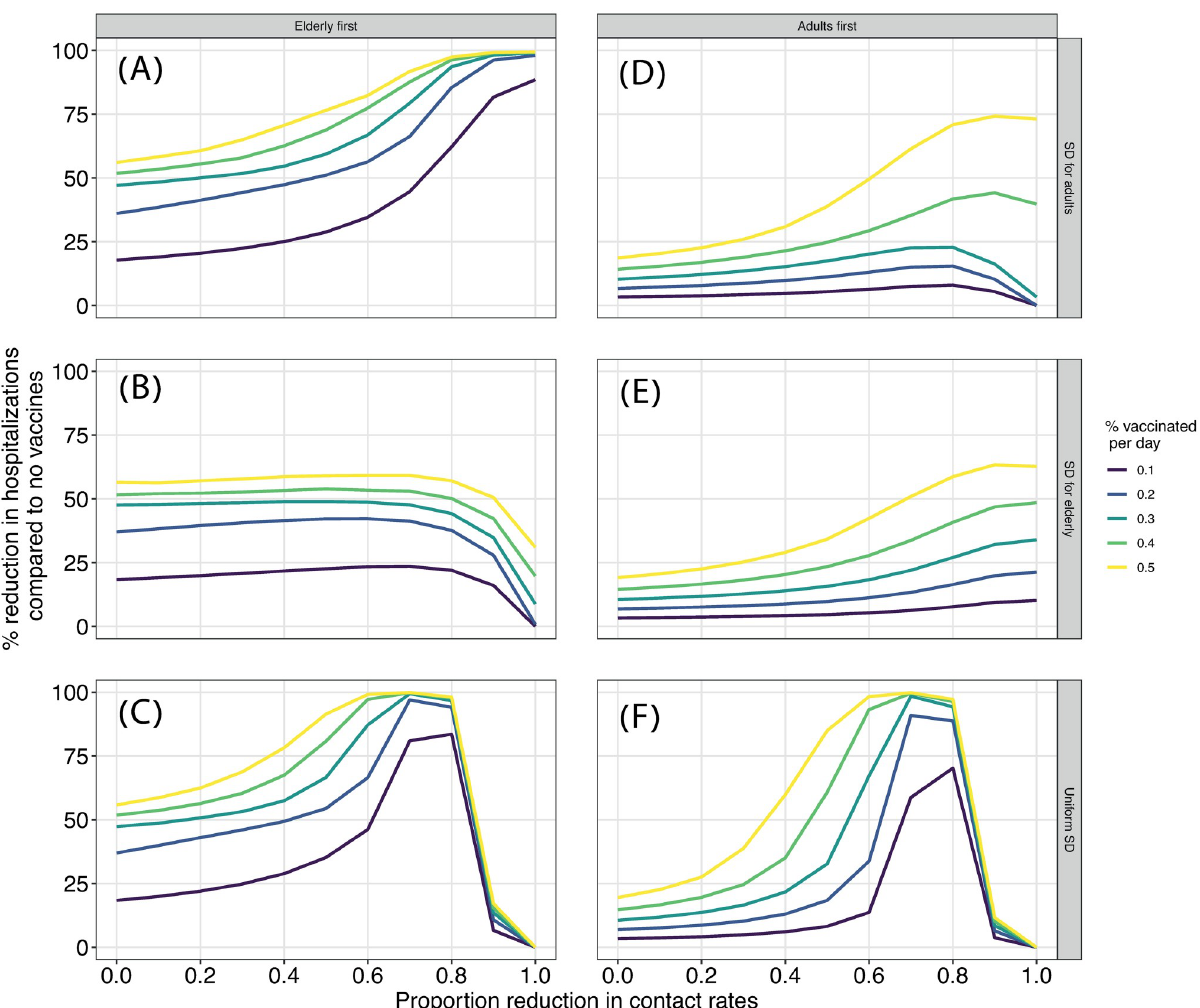
Fig 2. Effect of joint interventions on vaccination efficiency. The plot depicts F vaccination rates ( κ ; line colors), vaccination strategies (columns) and social distancing strategies (rows).